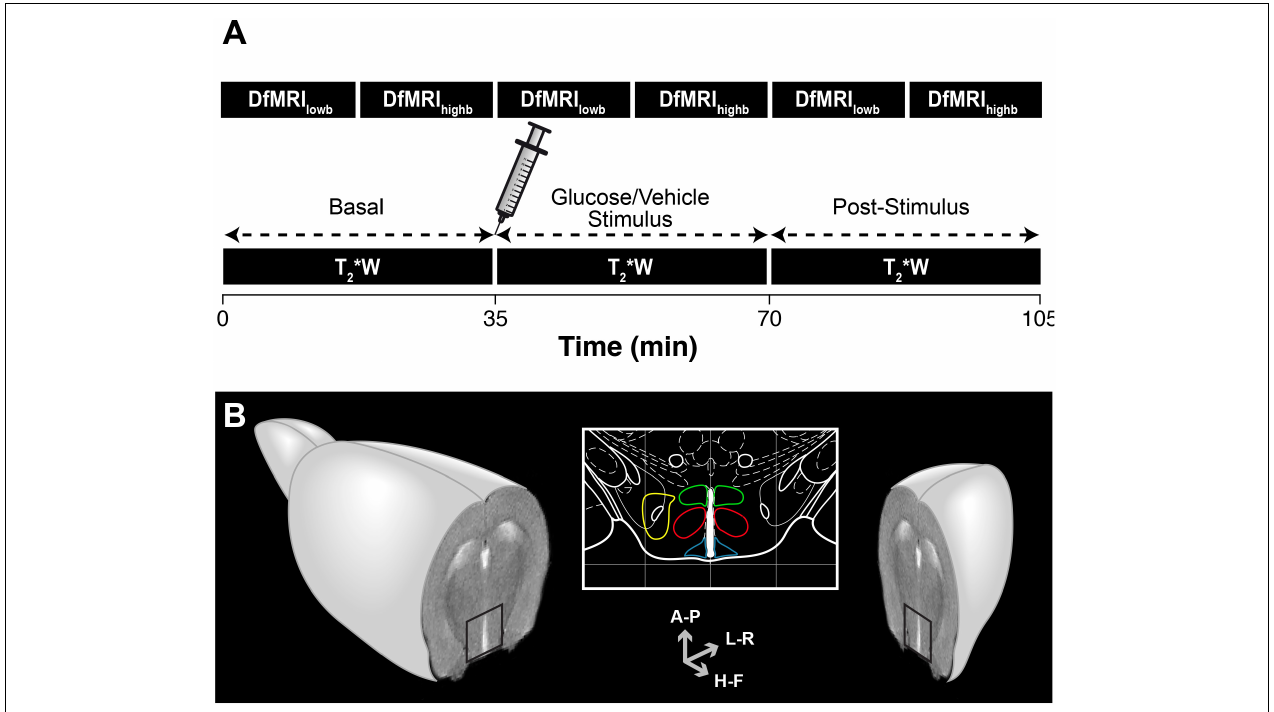
FIGURE 1 | Overview of the methodology implemented in the functional magnetic resonance imaging (fMRI) evaluation of hypothalamic glucose sensing. (A) Schematic representation of the MRI protocol. C57BL6/J mice were imaged using either high b or low b DfMRI or T 2 ∗ W methods. Serial DfMRI or T 2 ∗ W acquisitions were divided into basal (starting 35 min before the i.p. solution administration), Stimulus (up to 35 min following the i.p. injections) or post-stimulus , (starting 35 min. after the i.p. injections). (B) Axial MRI section of an idealized mouse brain containing the hypothalamus (black square). The hypothalamic nuclei are depicted in the mouse brain atlas insert: LH (yellow), VMN (red), DMN (green) and ARC (blue). Antero-Posterior (A-P), Left-Right (L-R) and Head-Foot (H-F) orientations of the diffusion